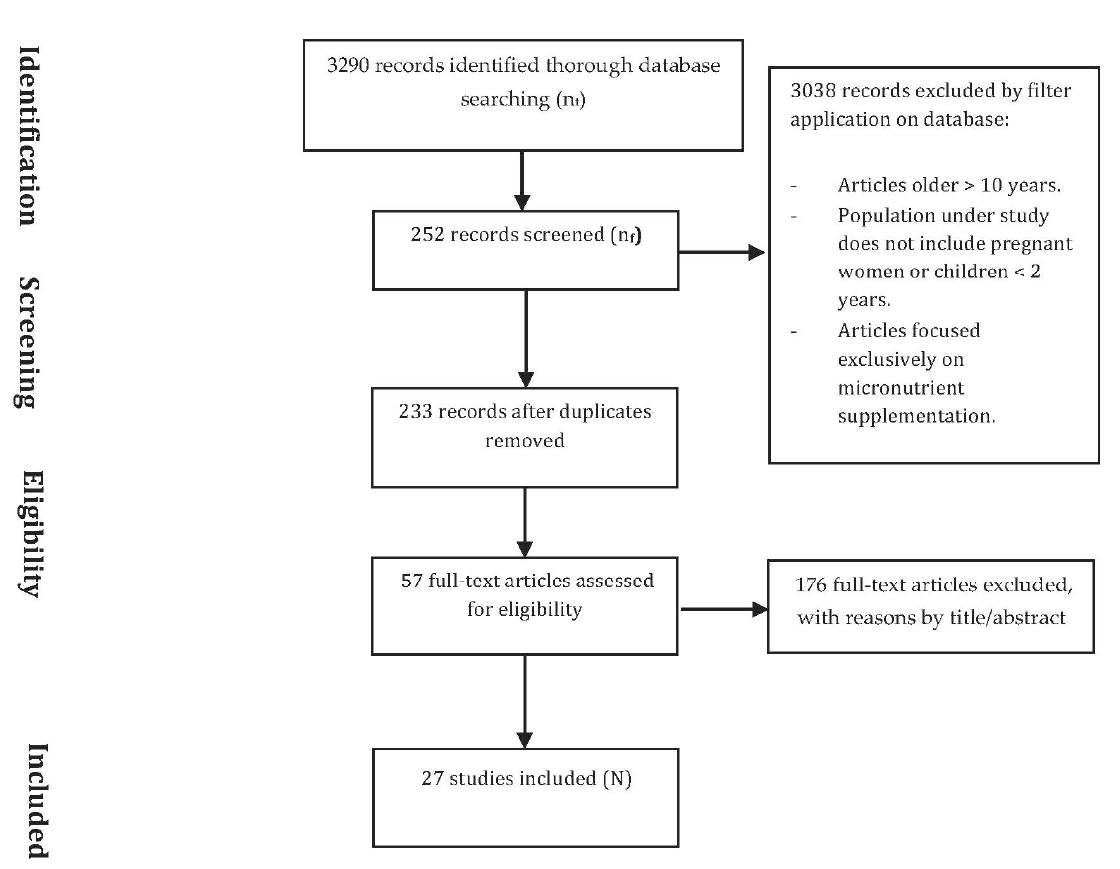
Figure 1. Flow chart showing the electronic research, identification, and selection process for the reviewed articles.